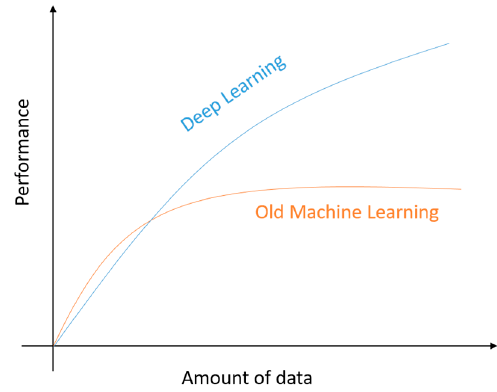
Figure 7. The performance of deep learning with respect to the amount of data.